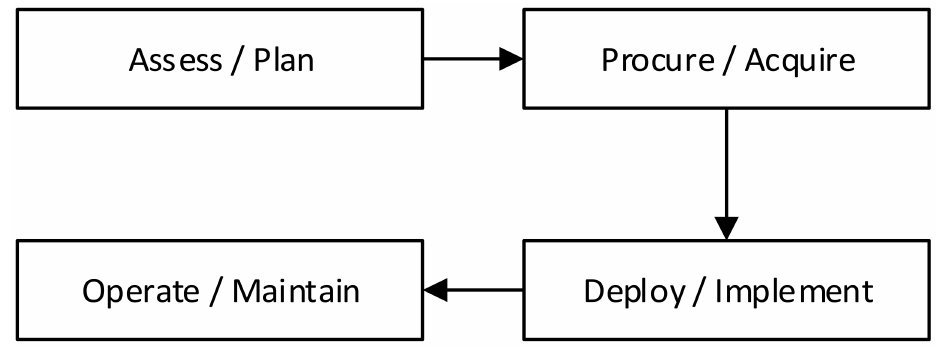
Figure 4. Notional BES cyber system lifecycle [15] NERC-CIP-013-1.